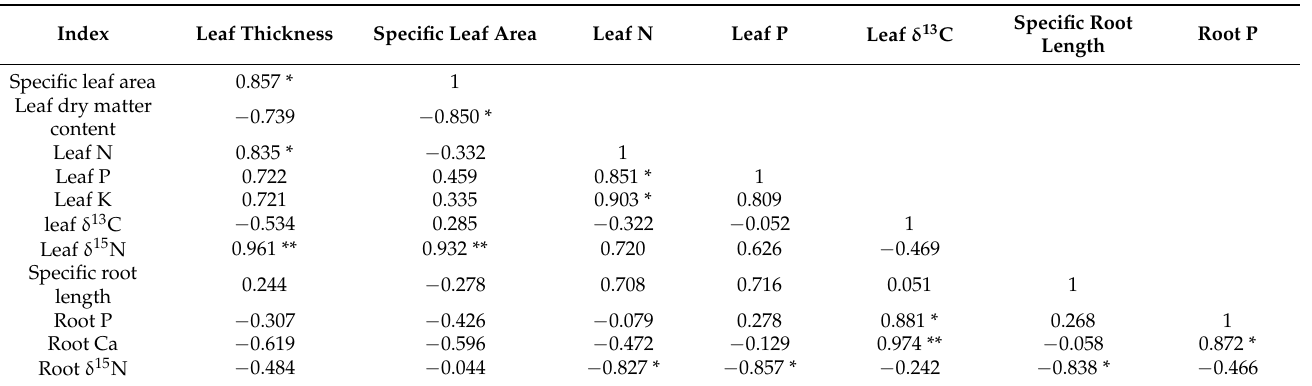
Table 5. Correlation analysis of main functional